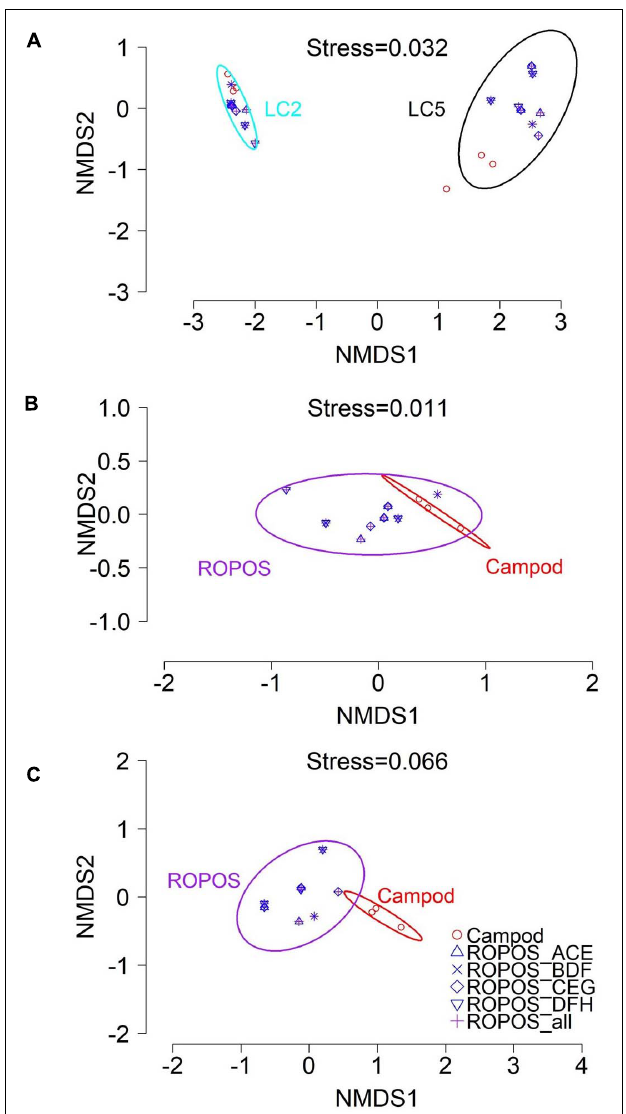
FIGURE 7 | Non-metric multi-dimensional scaling (NMDS) plot of the assemblages in the Laurentian Channel MPA (mean abundance m - 2 per transect for n = 23 aggregated taxa) using Bray-Curtis dissimilarity with 95% CI for station and tool groups, at (A) station LC2 and LC5; (B) station LC2 for each sampling design and (C) station LC5.